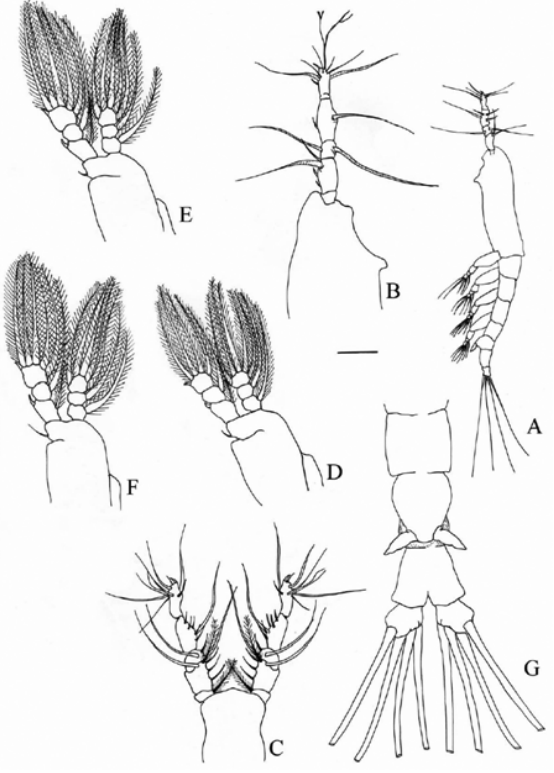
Fig. 3 – Cymbasoma longispinosum Bourne, 1890, m#. (A) Male lateral view; (B) Lateral view of the head; (C) Dorsal view of the head; (D) Leg 1; (E) Leg 2; (F) Leg 4; (G) Ventral view of the uro- some. Scale bar: A = 0.6 mm; B and C = 0.3 mm; D, E, F and G = 0.15